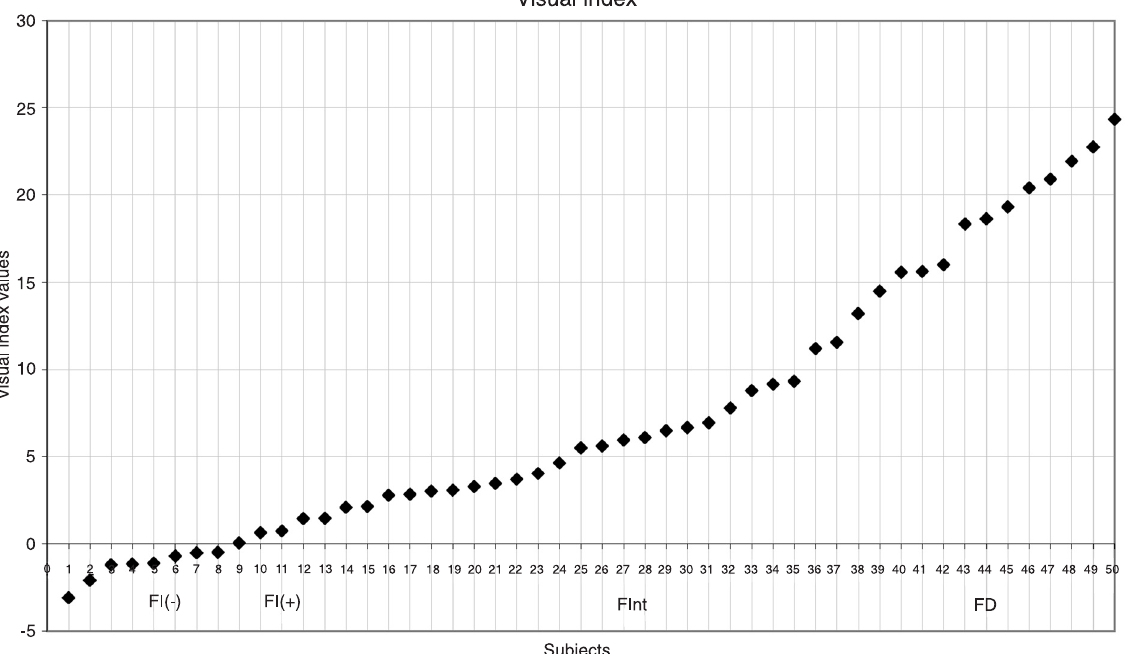
Figure 3. Distribution of visual index. FI(-) = field-independent negative values; FI(+) = field-independent positive values; FInt = field intermediate; FD = field-dependent